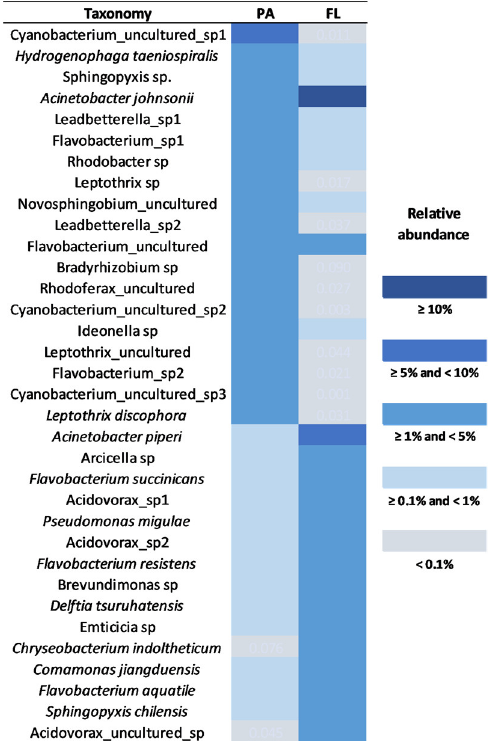
Figure 2. Heat map of relative OTU abundance in particle-attached (PA) and free-living (FL) communities. Particles refer to BA microplastics. Only OTUs that were abundant (≥1%) in the PA and/or FL communities are shown.